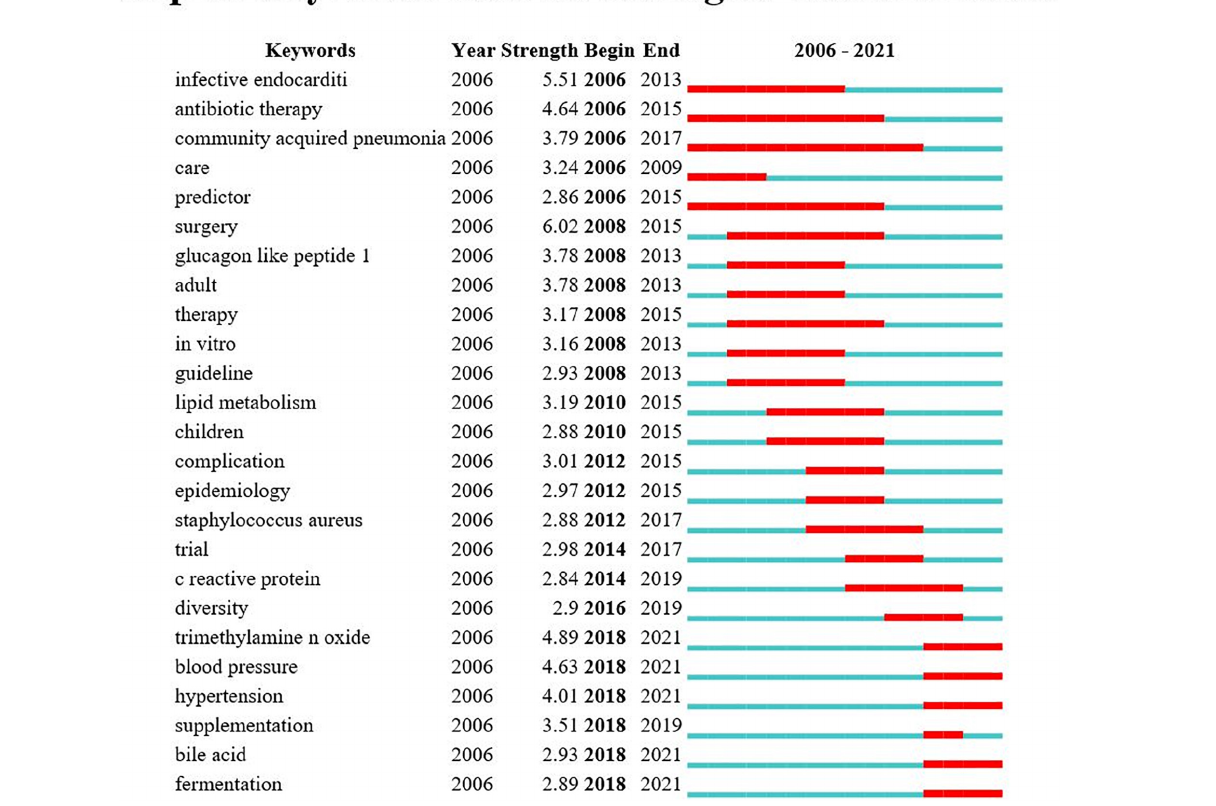
FIGURE 9 | Annual ranking of keywords with the strongest citation bursts related to gut microbiota research in the heart failure field. The strength values reflect the frequency of citation. Red bars indicate a burst period for the keywords.